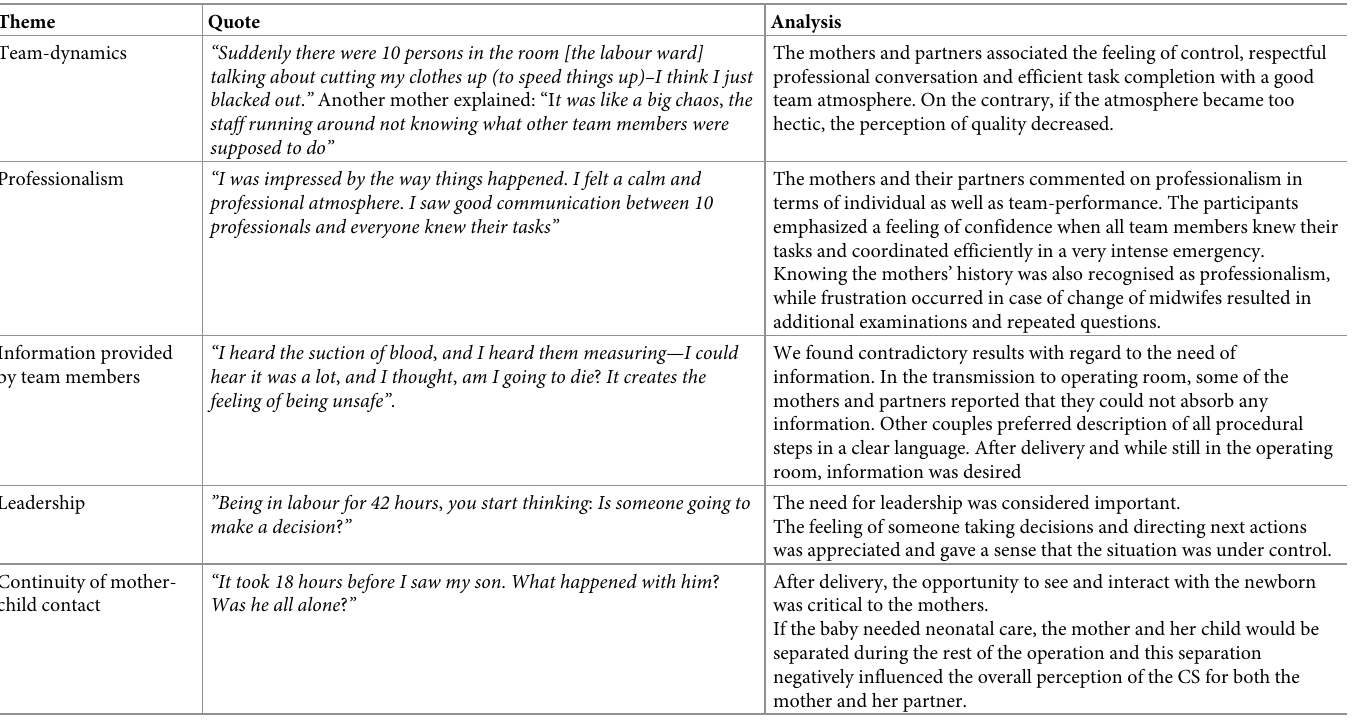
Table 2. Thematic analysis of interview transcripts with quotes.